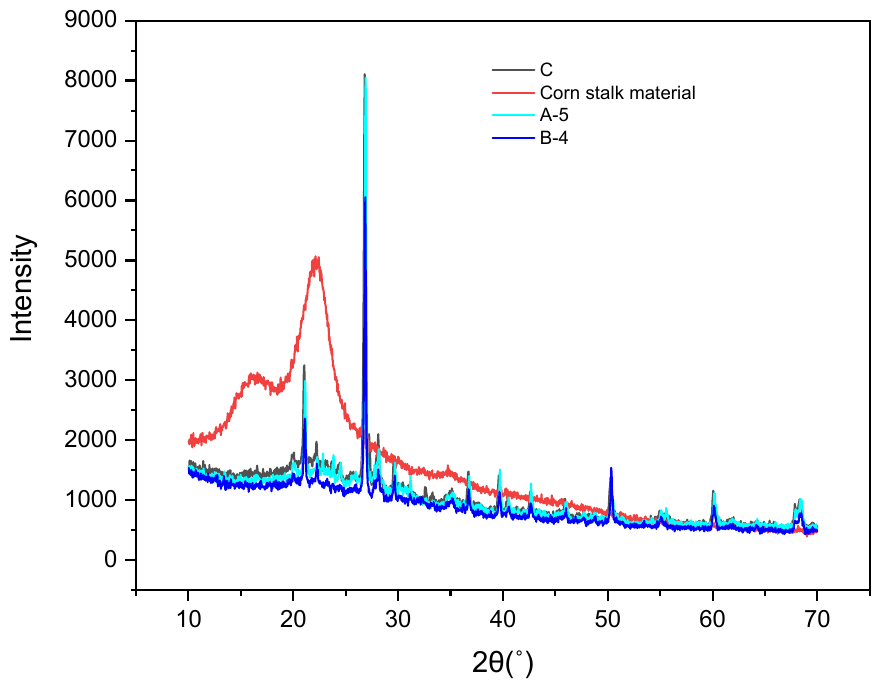
Figure 6. XRD images of corn stalk before and after fermentation.